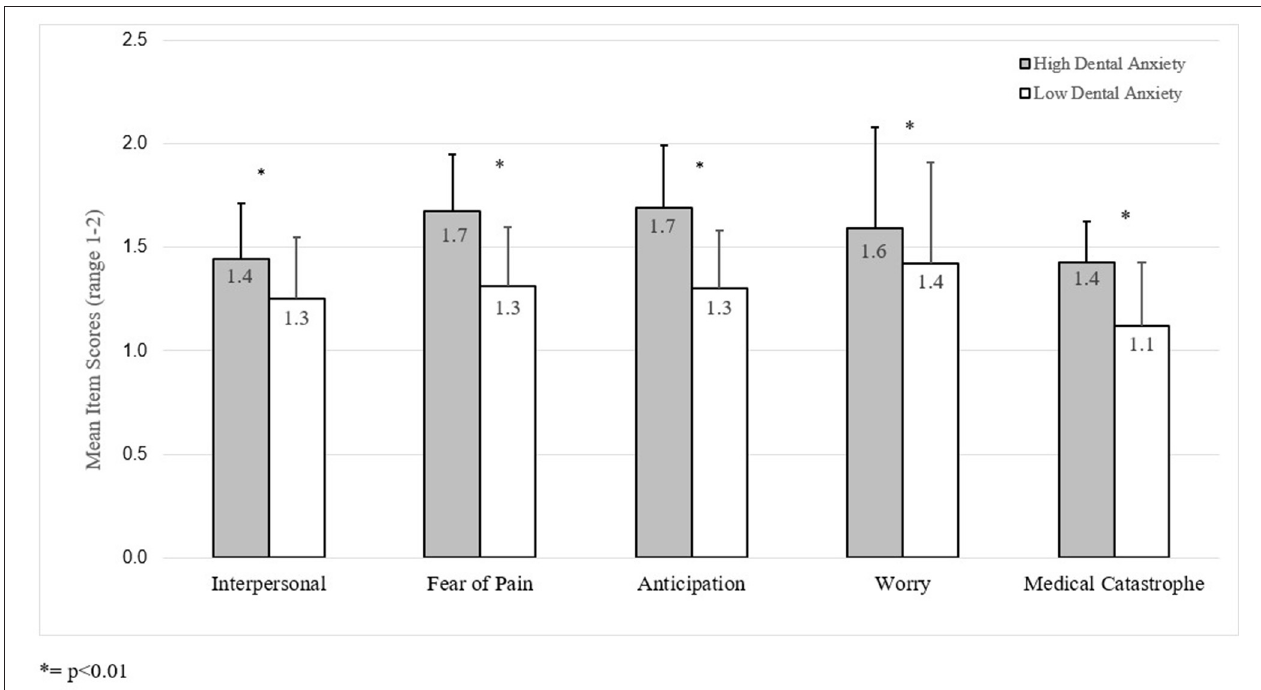
FIGURE 2 | MoDAIB scenario type mean scores by high and low dental anxiety (Testing Phase).